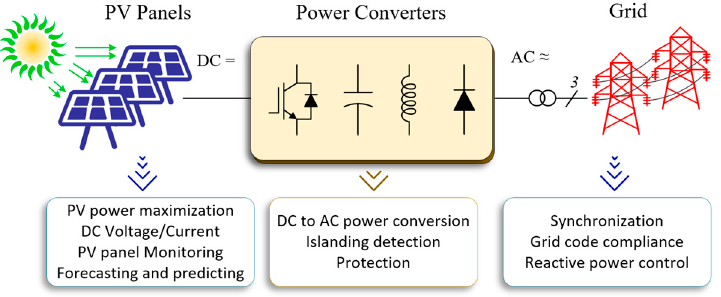
Figure 2. Photovoltaic conversion systems.